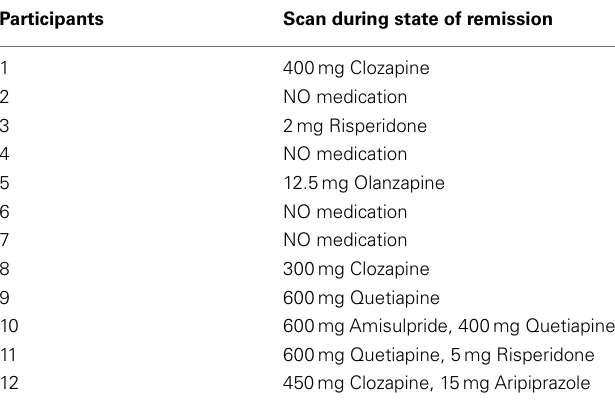
Table 2 | Individual subject medication protocol and